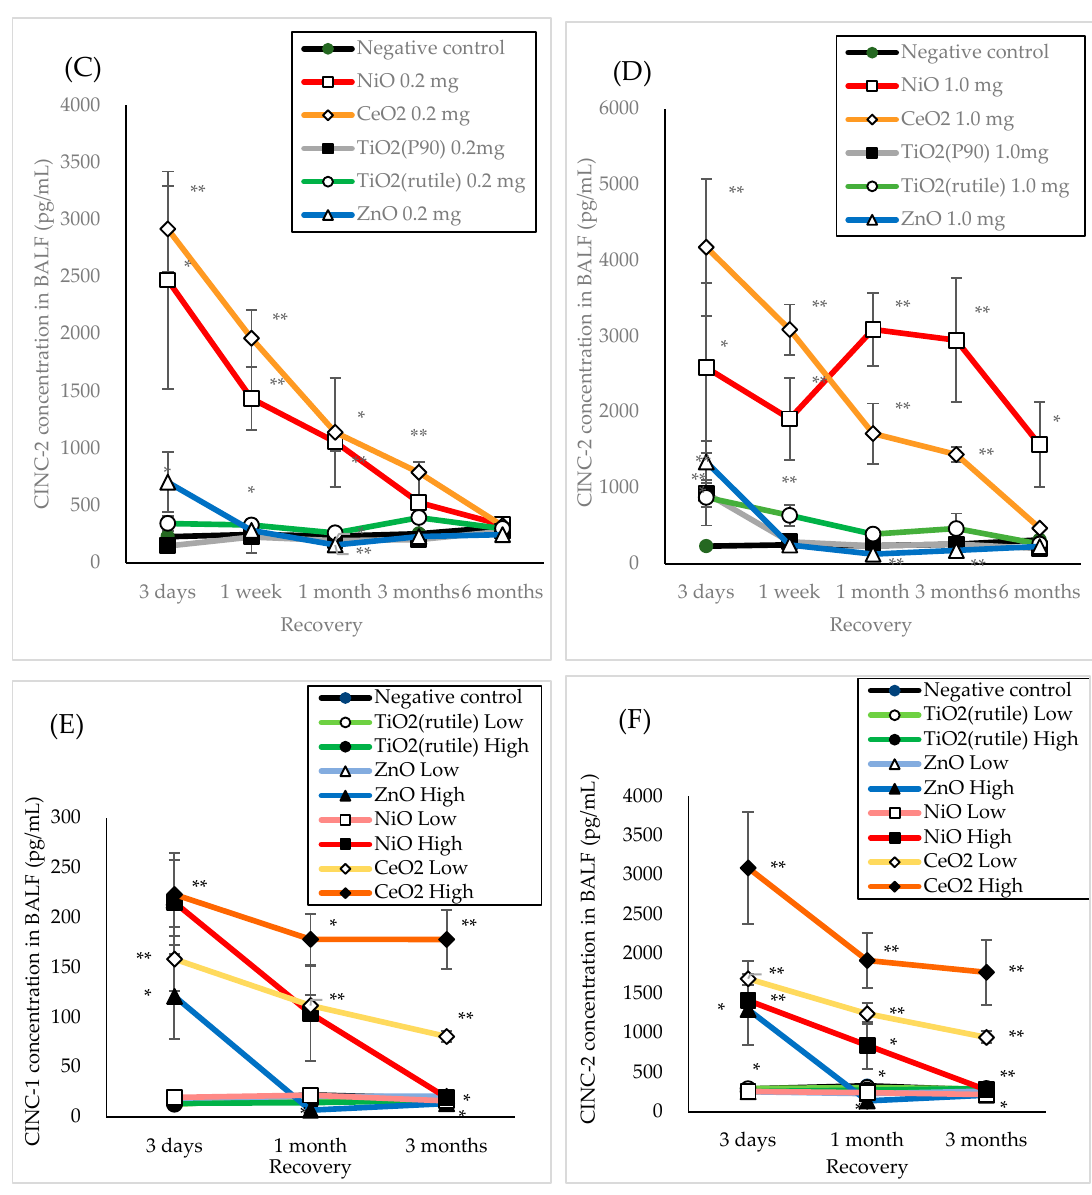
Figure 3. Cytokine-induced neutrophil chemoattractants (CINC)-1 and CINC-2 concentrations in BALF at each time point after intratracheal instillation and inhalation exposure of nanomaterials (NMs). ( A ) CINC-1 in low dose (0.2 mg/rat) of intratracheal instillation; ( B ) CINC-1 in high dose (1.0 mg/rat) of intratracheal instillation; ( C ) CINC-2 in low dose (0.2 mg/rat) of intratracheal instillation; ( D ) CINC-2 in high dose (1.0 mg/rat) of intratracheal instillation; ( E ) CINC-1 in inhalation exposure; ( F ) CINC-2 in inhalation exposure. Asterisks indicate significant differences compared with each control (analysis of variance and Dunnett’s test) (* p < 0.05, ** p < 0.01). Data point at each observation time represent average of 5 rats and the error bars show the standard deviations.